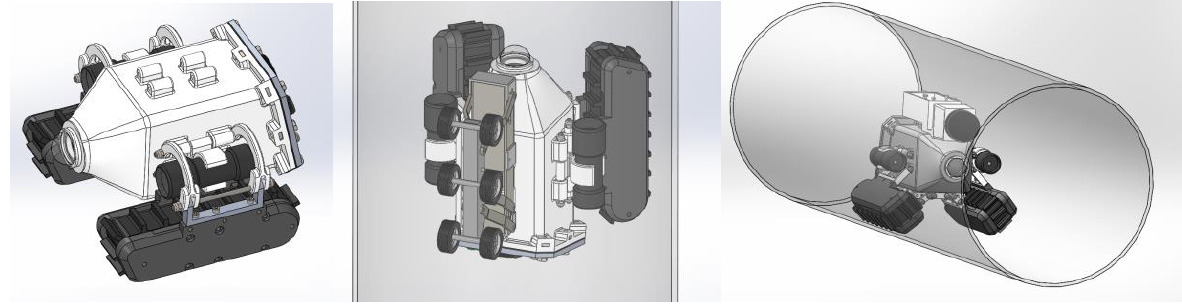
Fig. 1. Various configurations of the underwater crawler robot Figure 1: Various configurations of the underwater crawler robot.